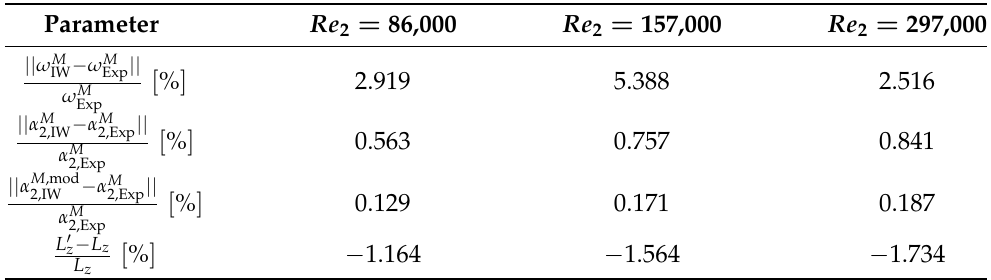
Table 2. Summary of percentage relative error between experimental and computational mixed-out quantity, as well as summary of the streamtube contraction